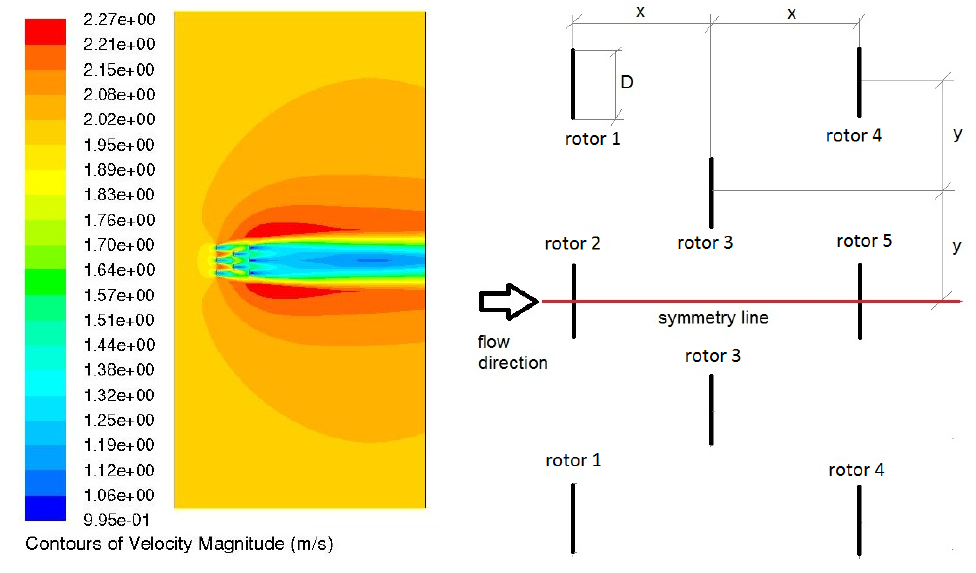
Figure 4. Velocity field around an 8-turbine